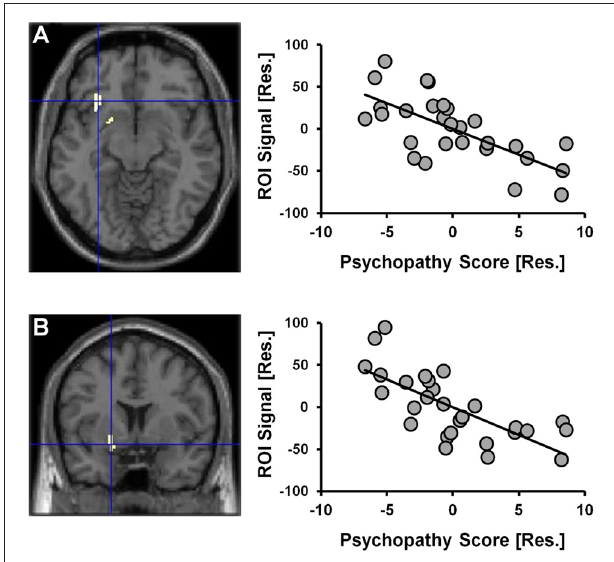
FIGURE 4 | CDMT PET outcomes as a function of psychopathy scores. Psychopathy scores were negatively correlated with rCBF in the right insula (A) and the right ventral striatum (B) during the CDMT. The images are the thresholded ( p cluster - corrected < 0.05; p voxel - level < 0.001) statistical parametric maps and depict the negative relation between the psychopathy score variable included in the one-sample t -test model from Figure 3C showing Run2-related effects (this model also controlled for DUS, sex and task performance metrics). To facilitate visual interpretation, the scatter plots depict residualized values for the variables shown on the x- and y-axes (indicated by [Res.]) where the influences of the controlled variables have been removed (scatter plots of the raw values can be found in Supplementary Figure S3). See Table 2 for coordinates of trait psychopathy-related brain clusters.